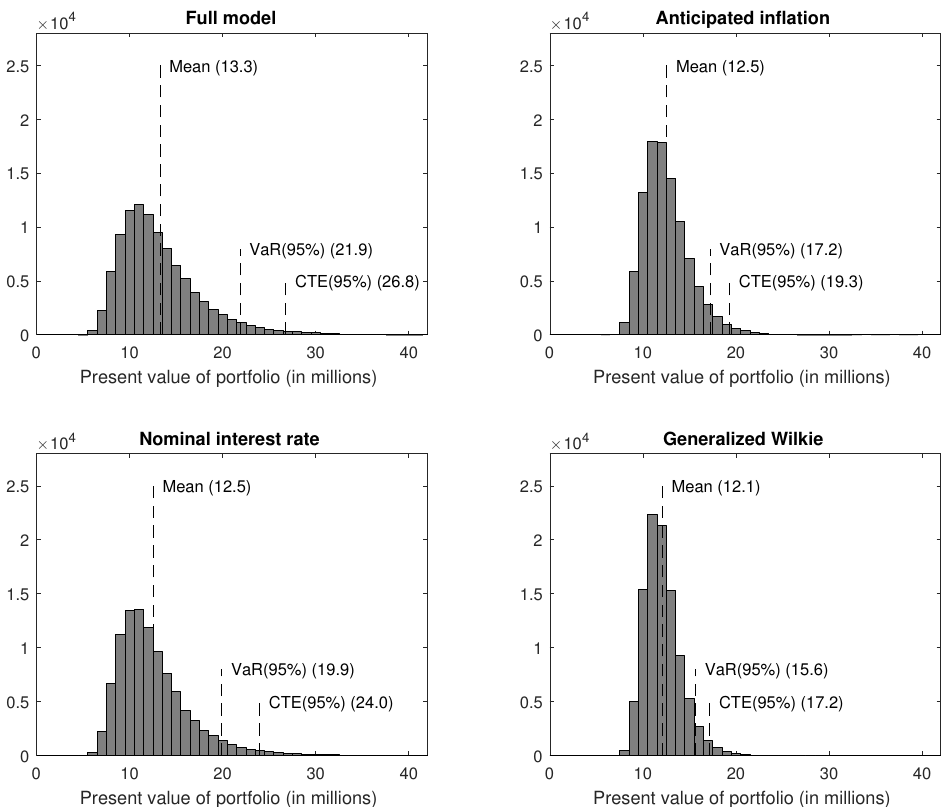
Figure 5. Histograms of life insurer’s future payments on 5 February 2014, in present value. Portfolio present values are simulated using the method presented in Section 5 for four different inflation assumptions: full inflation (top left panel), anticipated inflation (top right panel), nominal interest rate (bottom left panel), and generalized Wilkie model (bottom right panel). Then, histograms are plotted and risk-measures are calculated. Values are reported in millions. CTE refers to the conditional tail expectation and VaR means